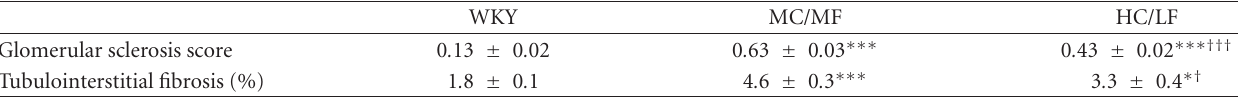
Table 2: Morphologic evaluation of glomerular sclerosis and tubulointerstitial fibrosis at the end of study.